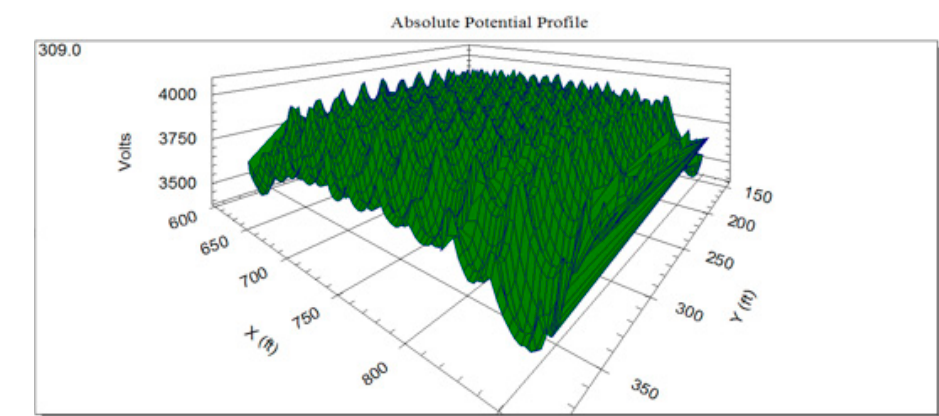
Figure 14. 3D plots of FEM mode absolute voltage.